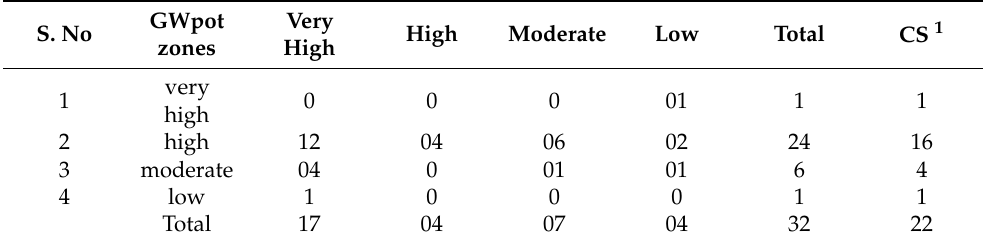
Table 5. Error matrix of the GW pot zone-based confusion matrix and Kappa (K) analysis. S. No